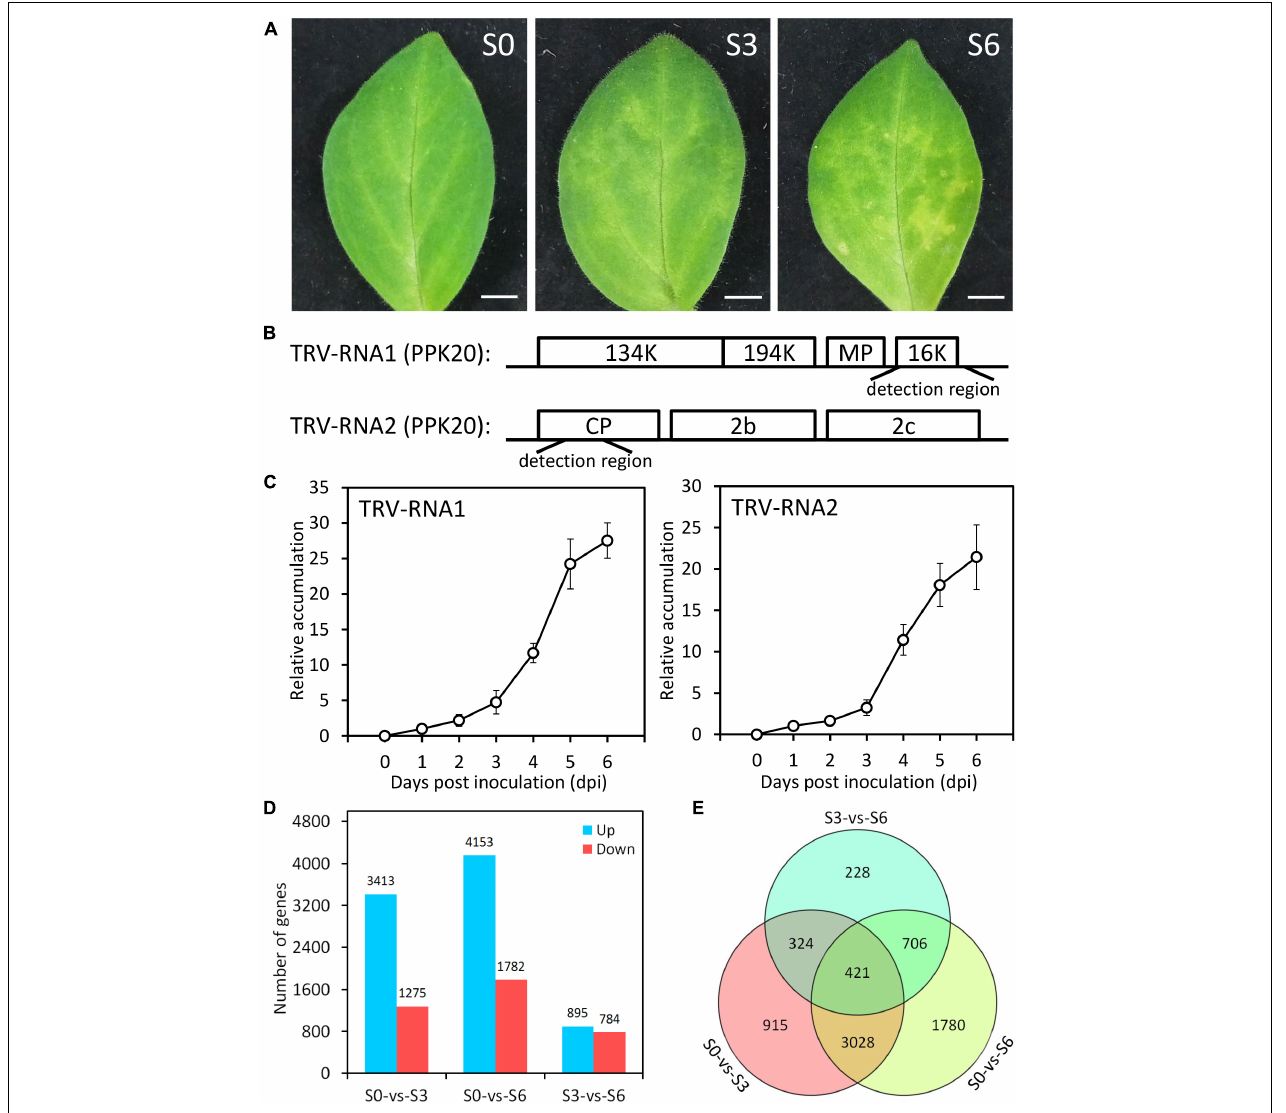
FIGURE 2 | Symptom development and transcriptome data evaluation in TRV PPk20-infected petunia leaves. (A) Representative phenotypes of petunia leaves at 0 (S0), 3 (S3), and 6 (S6) days post inoculation with TRV (PPK20). Scale bars = 5.0 mm. (B) Schematic diagram of the regions used for detection of TRV-RNA1 and TRV-RNA2 levels. (C) Relative accumulation levels of TRV-RNA1 and TRV-RNA2 in TRV (PPK20)-inoculated petunia leaves at intervals. Error bars represent standard error of the mean from three biological replicates. Transcript abundances were standardized to 26S rRNA . (D) Number of up-regulated and down-regulated unigenes in TRV (PPK20)-infected petunia leaves for the pairwise comparisons of S0-vs.-S3, S0-vs.-S6, and S3-vs.-S6. (E) Venn diagram of unique and shared differentially expressed unigenes for different pairwise